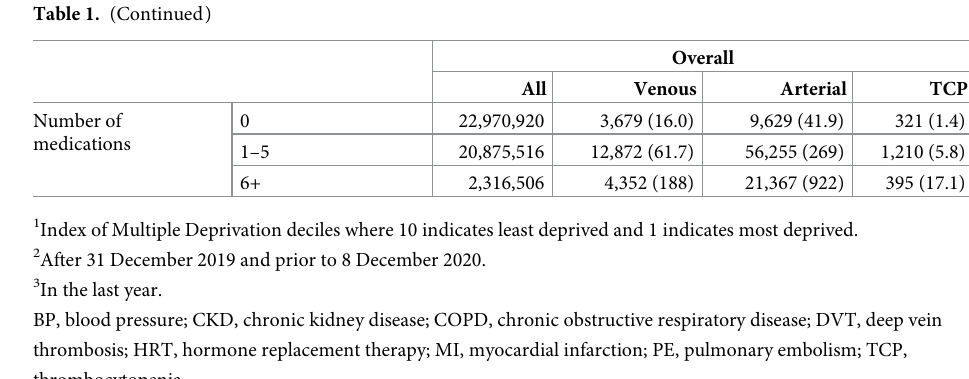
Corresponding HRs after BNT162b2 were 1.00 (0.75 to 1.34) and 0.97 (0.66 to 1.41). For those aged � 70 years, aHRs for thrombocytopenia 1 to 28 days after vaccination were similar for ChA- dOx1 (0.79, 95% CI: 0.56 to 1.10) and BNT162b2 (0.68, 0.51 to 0.90) (Fig 3, Tables 4 and 5). aHRs for the control condition lower limb fracture 1 to 28 days after ChAdOx1-S were 0.85 (95% CI: 0.77 to 0.93), and 0.83 (0.78 to 0.89) in people aged < 70 and � 70 years, respectively, compared with before vaccination. Corresponding aHRs after BNT162b2 were 0.93 (0.84 to